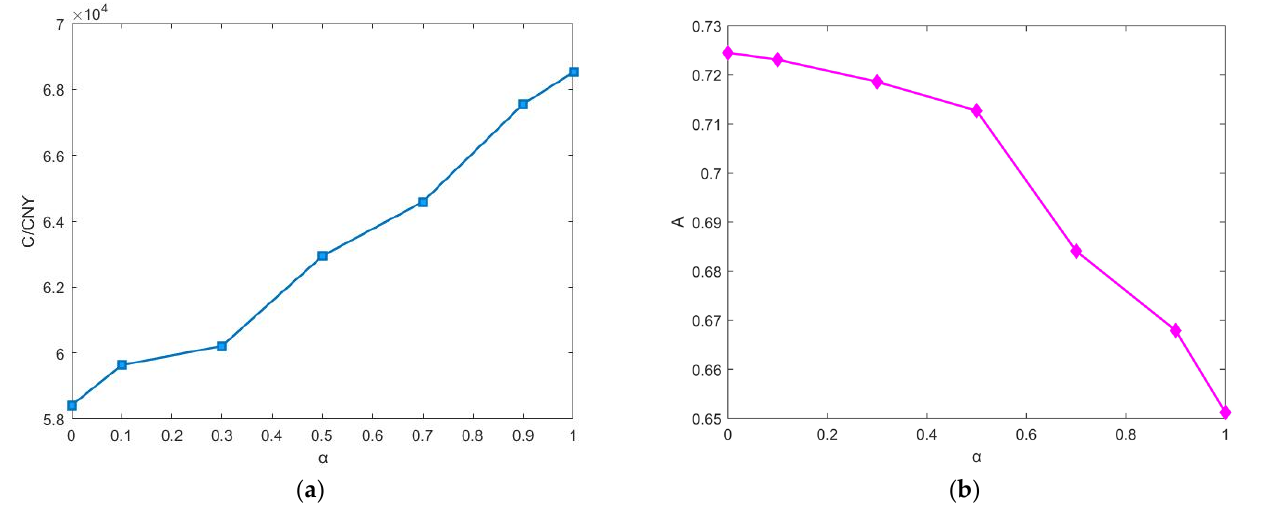
Figure 13. Sensitivity analysis of α . ( a ) Minimum warranty cost under different α , ( b ) The highest availability under different α .